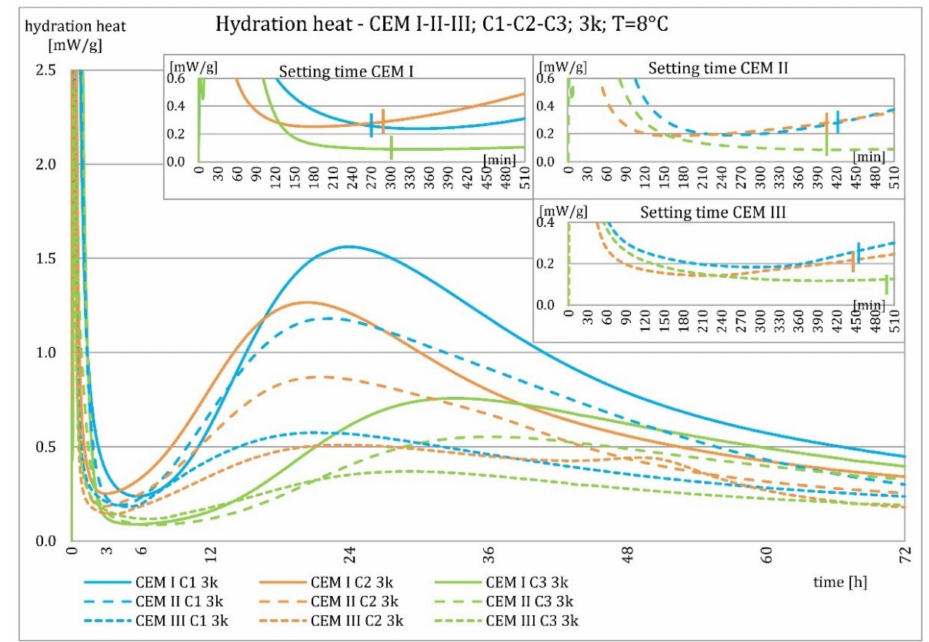
Figure 18. Hydration heat of C1-C2-C3 clinker based non-modified cements CEM I, CEM II/B-S, CEM III/A at 8 ◦ C.